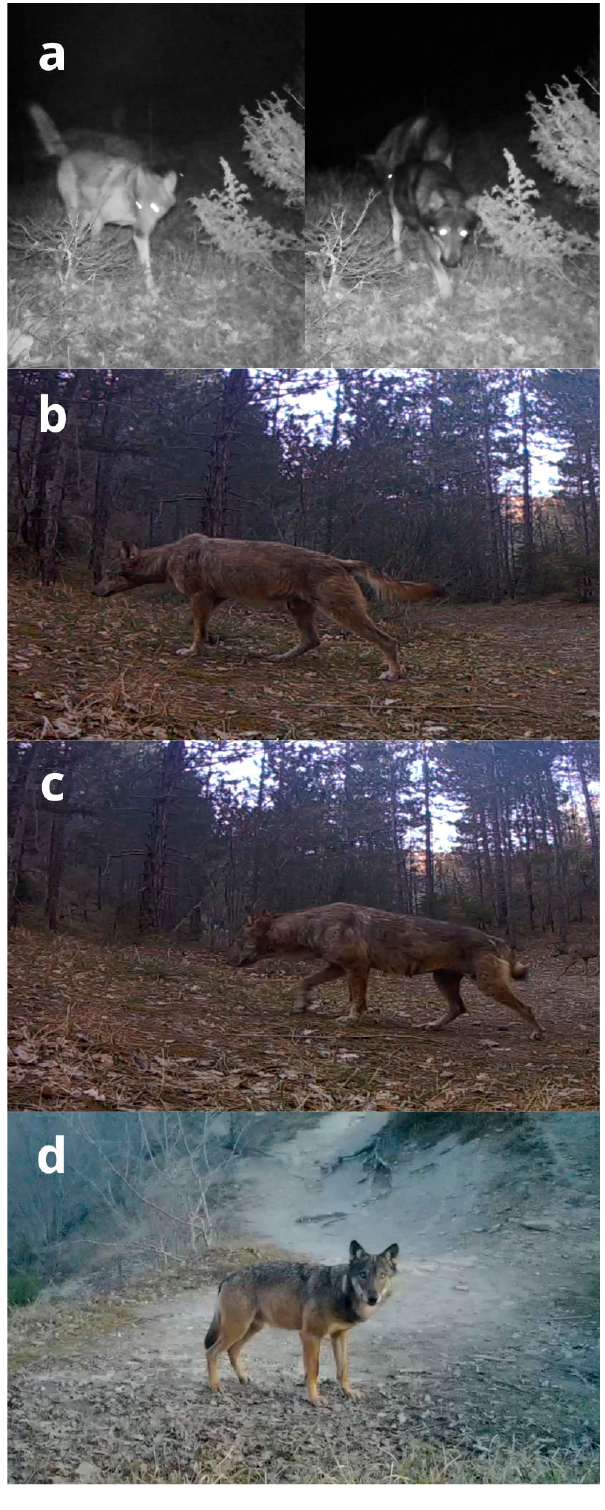
Figure 5. Screenshots from videos made during CT systematic sampling: ( a ) The dominant couple of P08, a wildtype female (on the left) and an almost completely black male (on the right), probably due to past wolf x dog hybridisation; ( b , c ) The dominant male ( b ) and the dominant female ( c ) of pack P11, both with mange during winter, a temporary characteristic; it is also possible to see in the picture of the dominant female one of her permanent characteristics, the short tail with a deformation on the top. ( d ) A healthy male wolf with a typical wild-type phenotype, for comparison.